Question: In one sentence, what is this figure communicating?
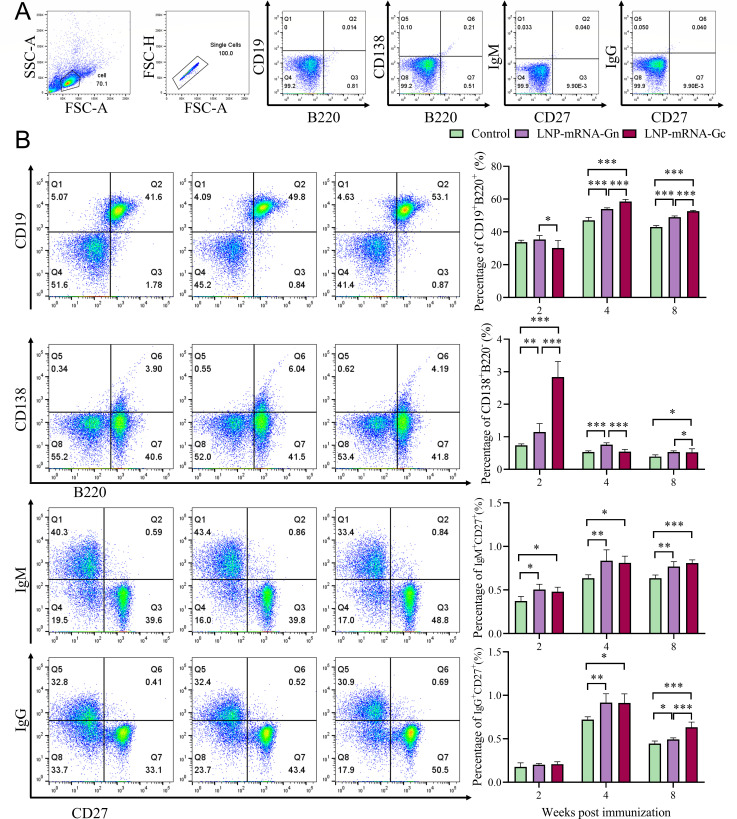
Answer: Activation of B cells in the spleen. ( A ) Gating strategies for analyzing B cells. ( B ) Spleens were collected at 2, 4, and 8 weeks postimmunization. Single-cell suspensions were prepared and stained separately with antibodies against B cells (CD19 + , CD138 + , CD27 + , B220 + , IgG + , and IgM + ). A representative flow cytometric plot of activated B cells is shown. Statistical analysis of the percentages of activated B cells in the spleen (15 wild-type mice per group; 5 mice per group per time point; values are means ± SEM; ANOVA with Tukey’s multiple comparisons test). * P < 0.05, ** P < 0.01 and *** P < 0.001.